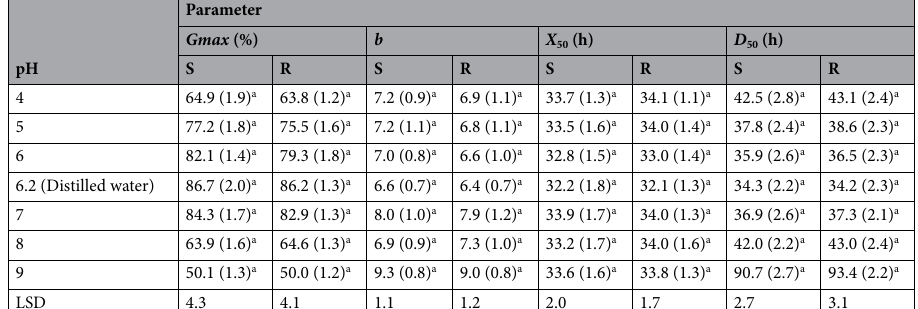
Table 5. Parameter estimates resulted from the fitting of three-parameter sigmoidal function to seed germination data associated with herbicide-resistant (R) and -susceptible (S) winter wild oat biotypes over time under different pHs. The values in parentheses denote standard error. Similar letters denote insignificant difference between the R and S biotype in each parameter. Gmax : maximum germination percentage; b : slope at X 50 ; X 50 : time to 50% of maximum germination at each temperature; D 50 : time to 50% germination.